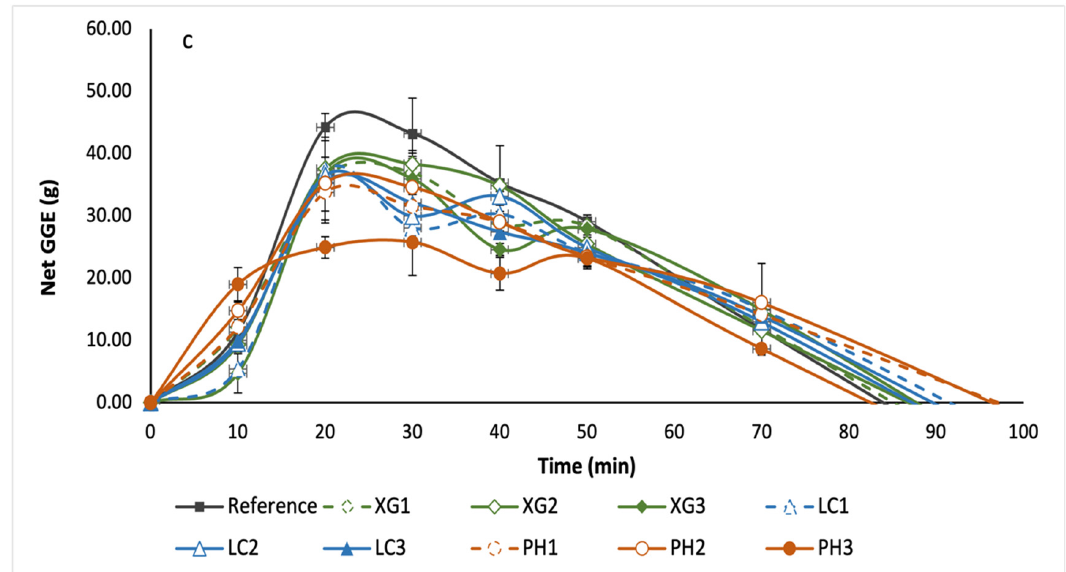
Figure 5. ( a ) GGE release curves show the overall accumulated glucose release over time; ( b ) GGE disposal curves show theoretical accumulated glucose disposal over time; and ( c ) net GGE curves obtained by subtracting GGE disposal from GGE release. All data are based on a dry weight basis of bread samples. Table 2. Bread formulations and the respective IAUC, RGP and RDS values based on dry weight. Formulation IAUC